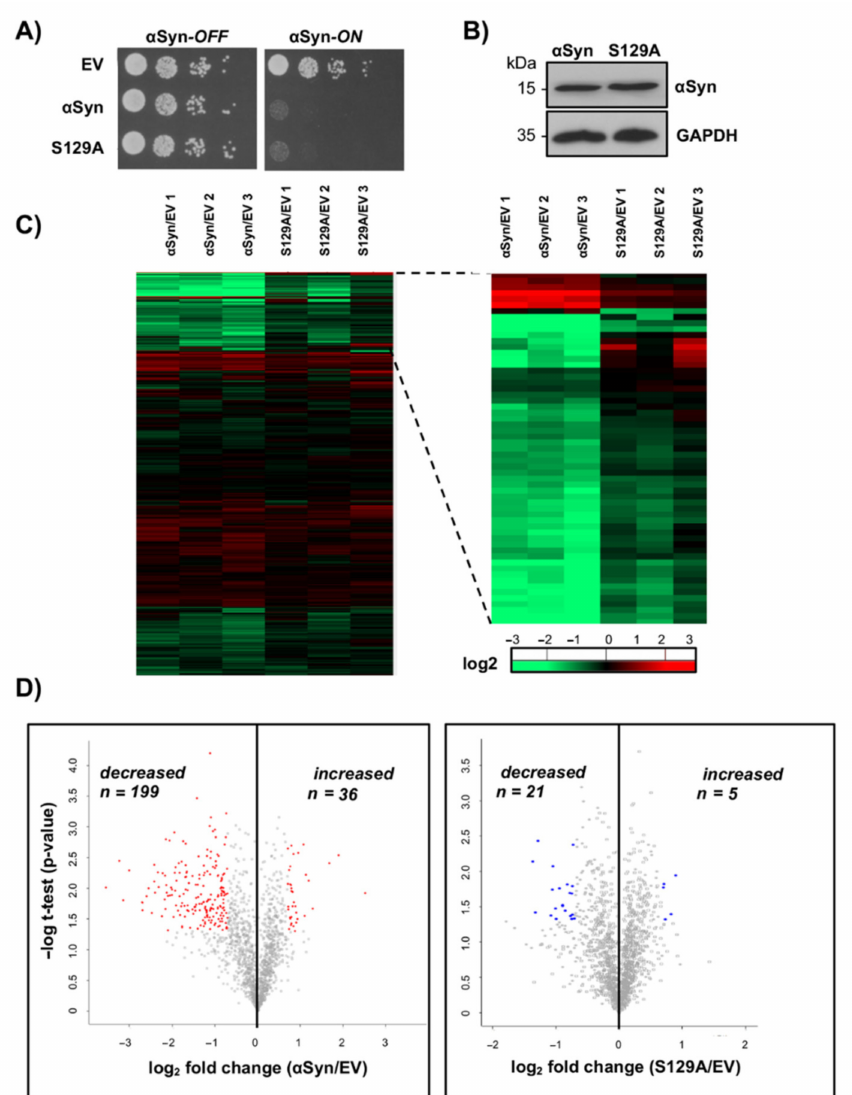
Figure 2. Expression of α Syn changes significantly the relative protein abundance, whereas S129A has less impact on the yeast proteome. ( A ) Growth assay of yeast cells expressing GAL1 -driven α Syn or S129A from a 2 µ plasmid with an empty vector (EV) as a control. Cells were spotted in 10-fold dilutions on selective plates containing glucose ( α Syn- OFF ) or galactose ( α Syn- ON ). ( B ) Western blot analysis with protein crude extracts of cells expressing α Syn or S129A after overnight induction in SILAC strain RH3493. GAPDH was used as a loading control. ( C ) Heatmap of the protein enrichment relative to the empty vector control (EV) ( n = 3; isotope label-swap replication). Colors indicate the levels of enrichment: green—downregulation; red—upregulation; black—non-significantly regulated. The right panel represents magnification of the indicated section. ( D ) Volcano plot analysis. Proteins were ranked according to their statistical p -value (y-axis) and their relative abundance ratio (log2-fold change) (x-axis). The threshold for significance was p ≤ 0.05 and log2-fold change ≤ − 0.7 or ≥ 0.7. Proteins with significantly changed abundance upon α Syn or S129A expression are colored in red or blue,